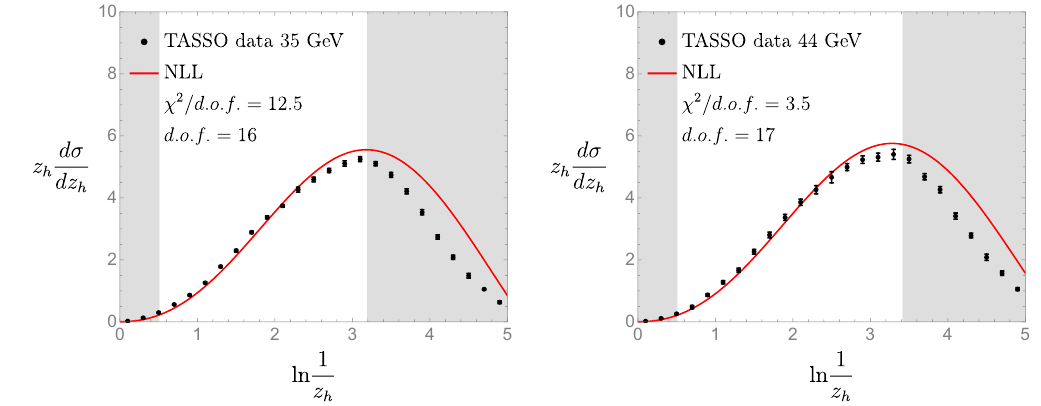
Figure 2 . The fragmentation spectrum for e + e − → h ± + X at center of mass energies Q = 35 and 44 GeV. The gray region is excluded from the χ 2 / d.o.f. determination based on hadron mass corrections or z (1) , and the quoted χ 2 / d.o.f. is the goodness-of-fit for that data set alone h ∼ O using the best fit